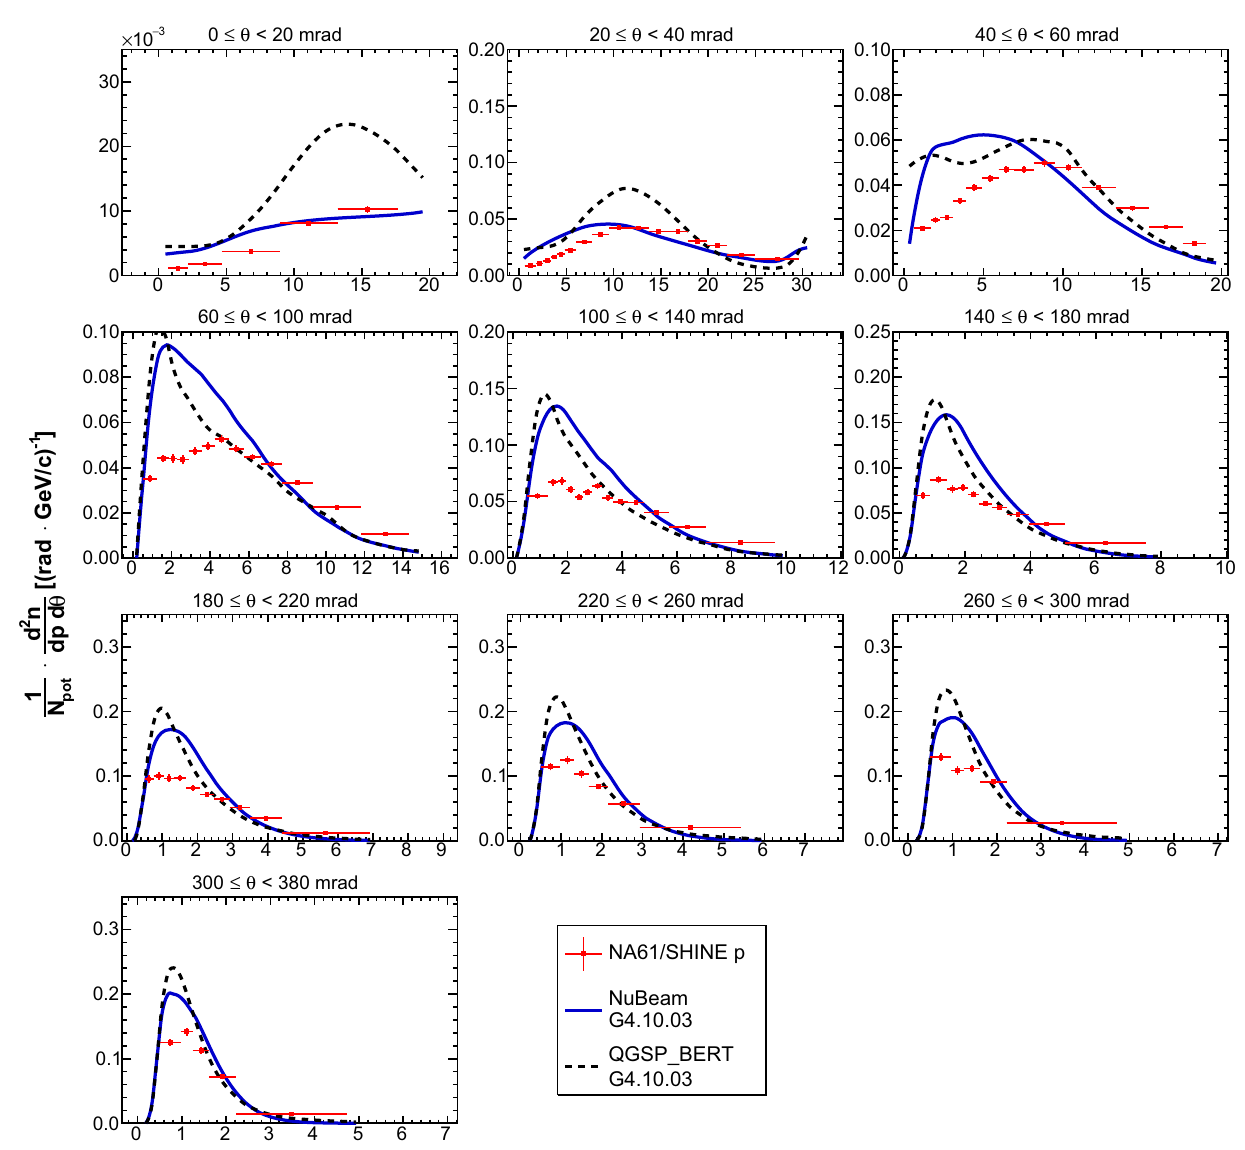
QGSP_BERT (dashed black line) physics lists from Geant4.10 .03 [27,28] are overlaid on top of the